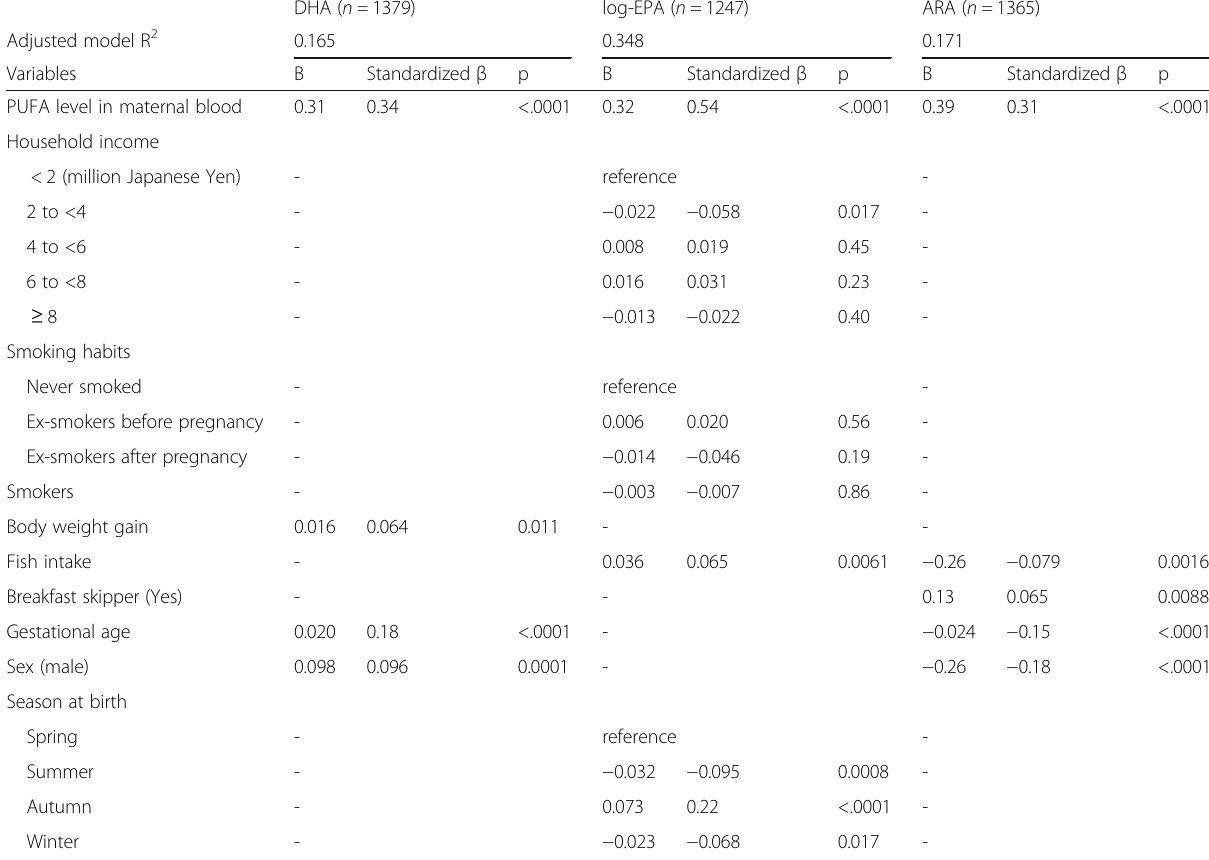
Table 6 Multiple stepwise regression analyses for determinants of PUFA levels in cord blood